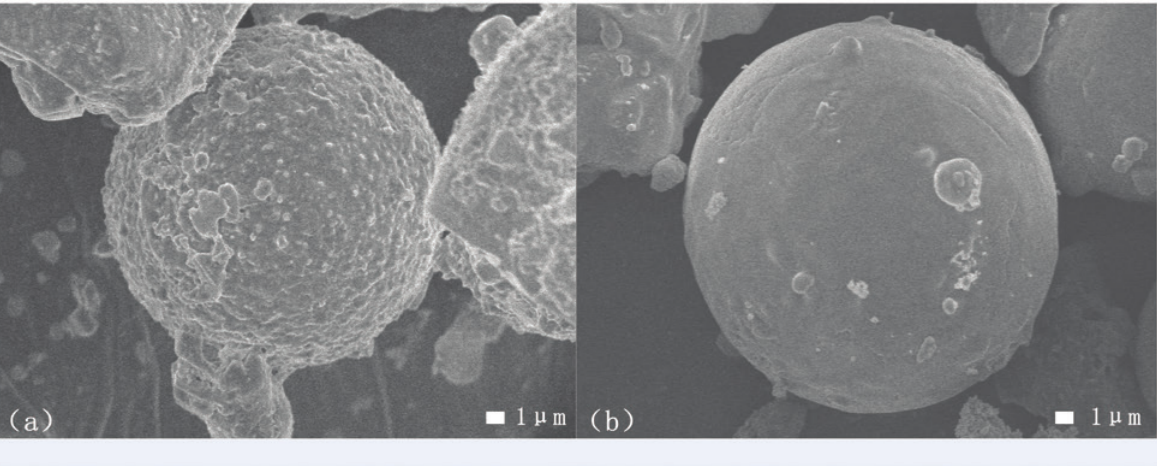
/Ag composite spheres after thermal annealing under different temperature conditions. (a) annealing below Figure 4: SEM images of SiO 2 800 ° C; (b) annealing below 900 ° C.